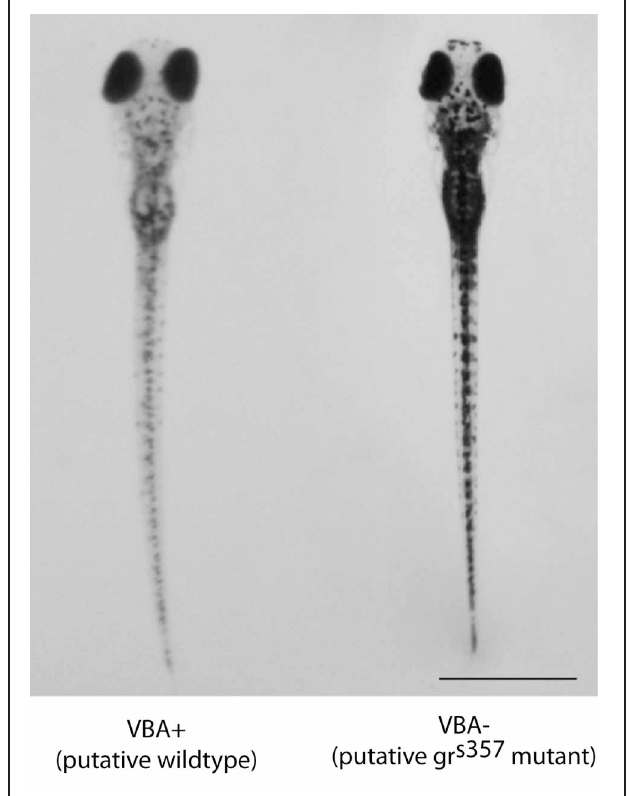
FIGURE 2 | Representative photographs of a VBA + (left) and VBA − (right) larva from the same clutch after exposure to the VBA stimulus on day 5 post-fertilization. The dark fish were reproducibly genotyped and shown to be homozygous gr s357 mutants. Non-dark siblings were either homozygous wildtype or heterozygotes. Scale bar =